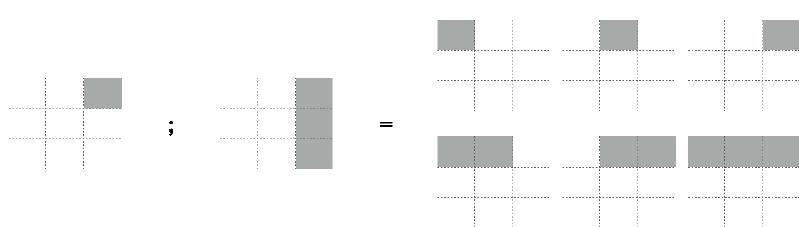
Figure 2: The weak composition of direction relation matrix symbols (NE) and (NE,E,SE). Not all members of these direction relation symbols can result in all of these resultant ele- ments.